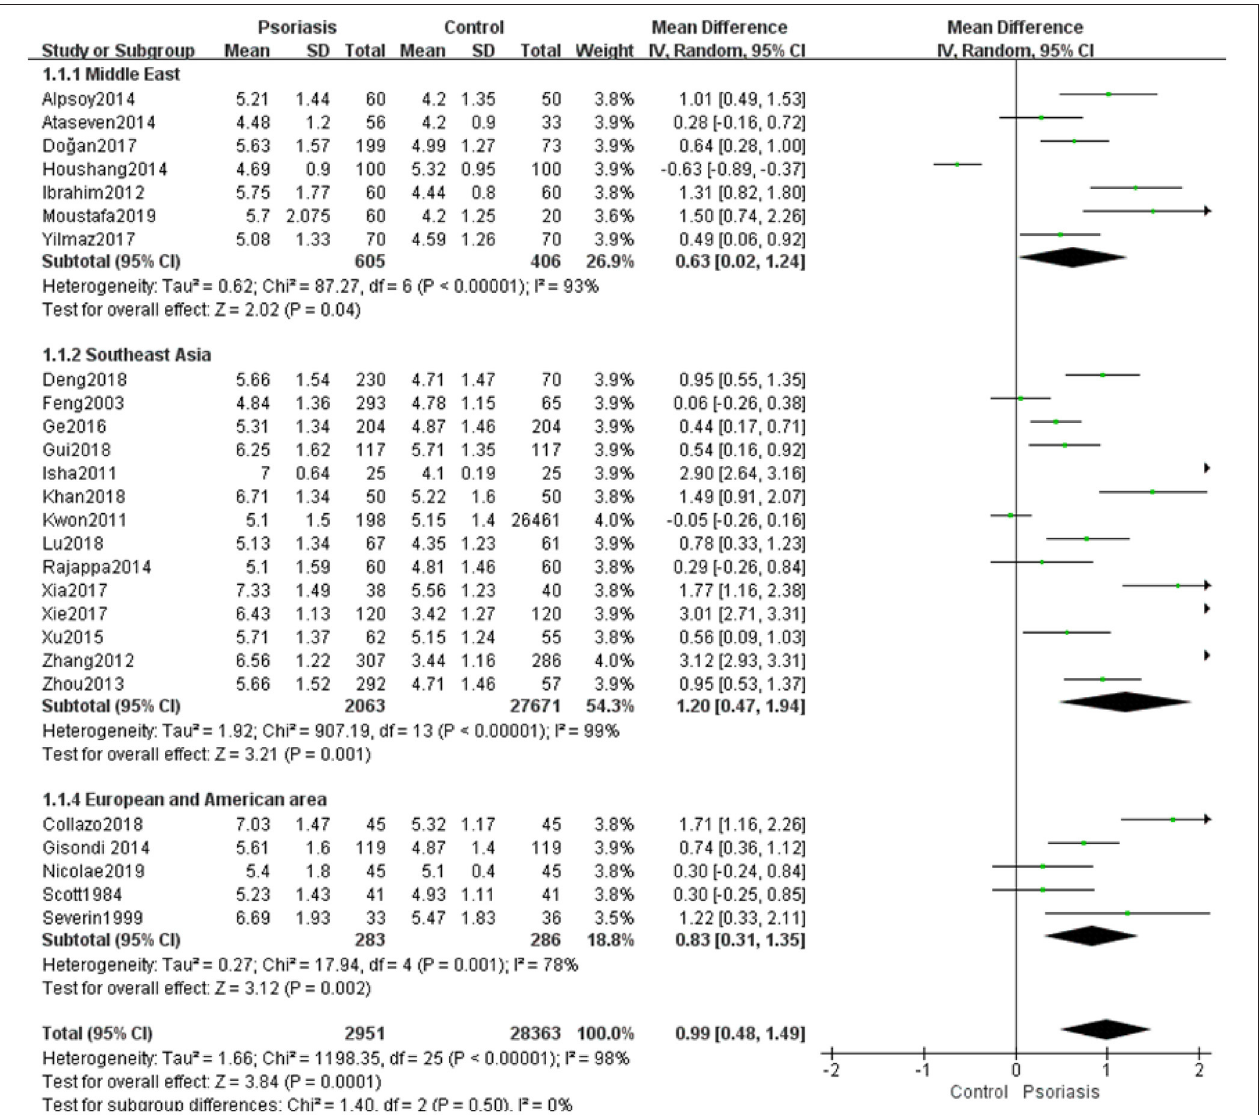
FIGURE 2 | Meta-analysis of the SUA levels of patients with psoriasis vs. controls. The MD in SUA levels of patients with psoriasis compared with controls. The point estimate (center of each green square) and statistical size (proportional area of the square) are represented. The horizontal lines indicate the 95% confidence intervals. The subtotal and total MD (diamond) were calculated using a random-effects model. MD, mean difference; SUA, serum uric acid.